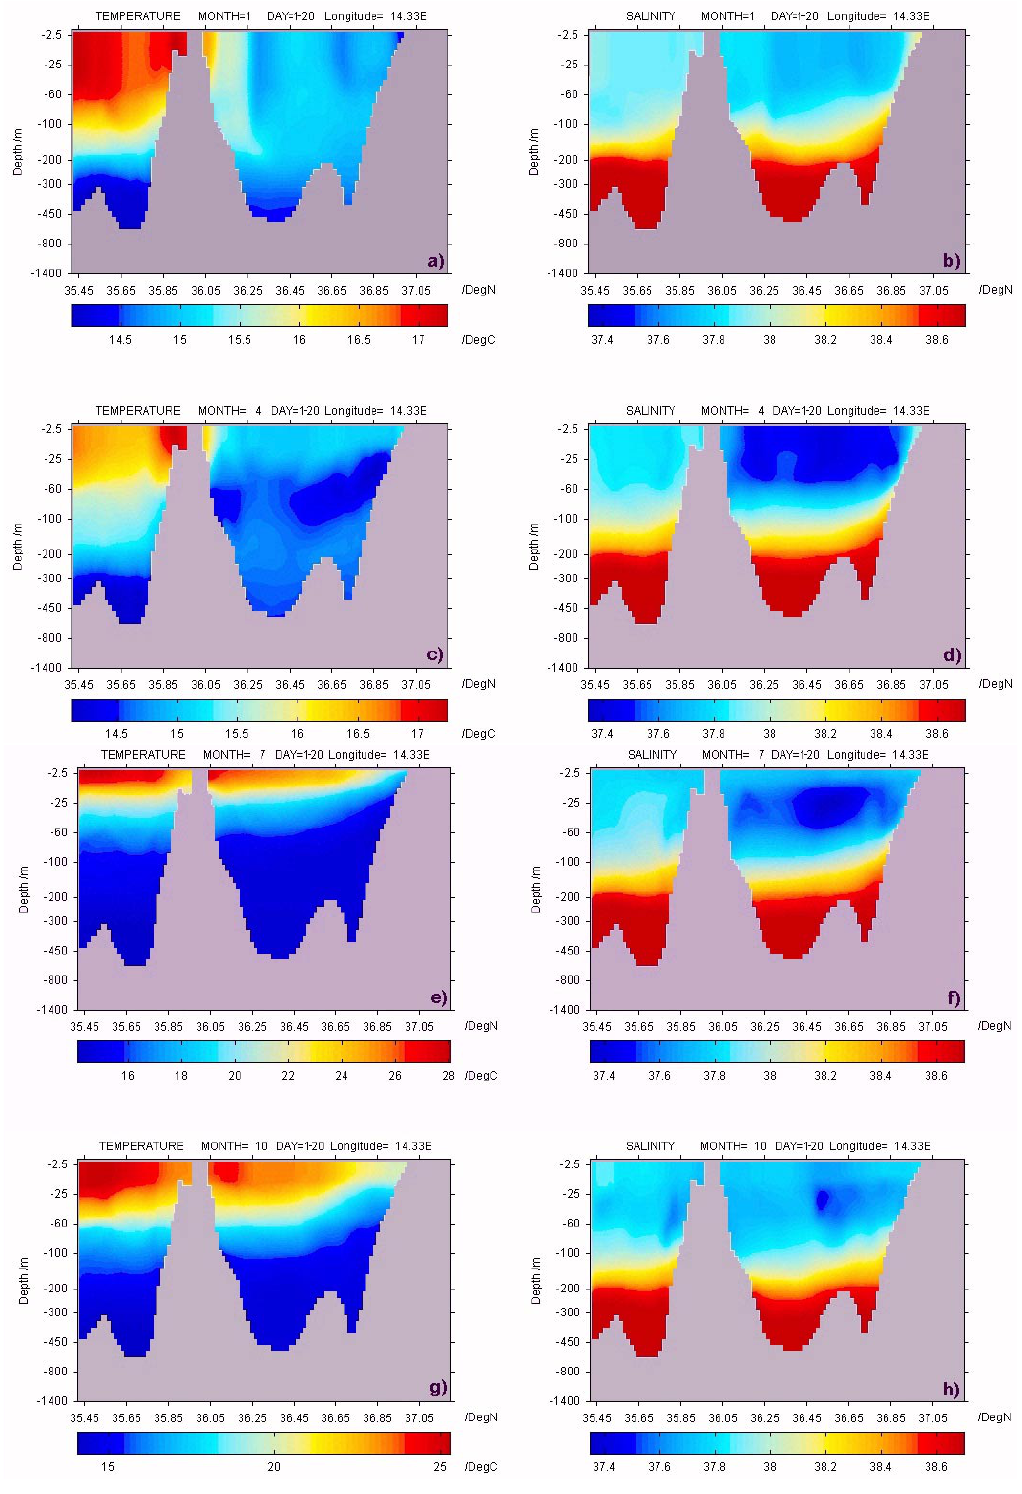
Fig. 12. Vertical sections of ten-day averaged temperature and salinity for the second third of January (a) , and (b) , and for the second third of April (c) and (d) . The section runs from south to north along longitude 14 ◦ 20 0 E. Plotting of velocity vectors is done only at every odd grid point. Vertical sections of 10-day averaged temperature and salinity for the second third of July (e) and (f) , and for the second third of October (g) and (h) . The section runs from south to north along longitude 14 ◦ 20 0 E. For plotting of velocity vectors is done only at every odd grid